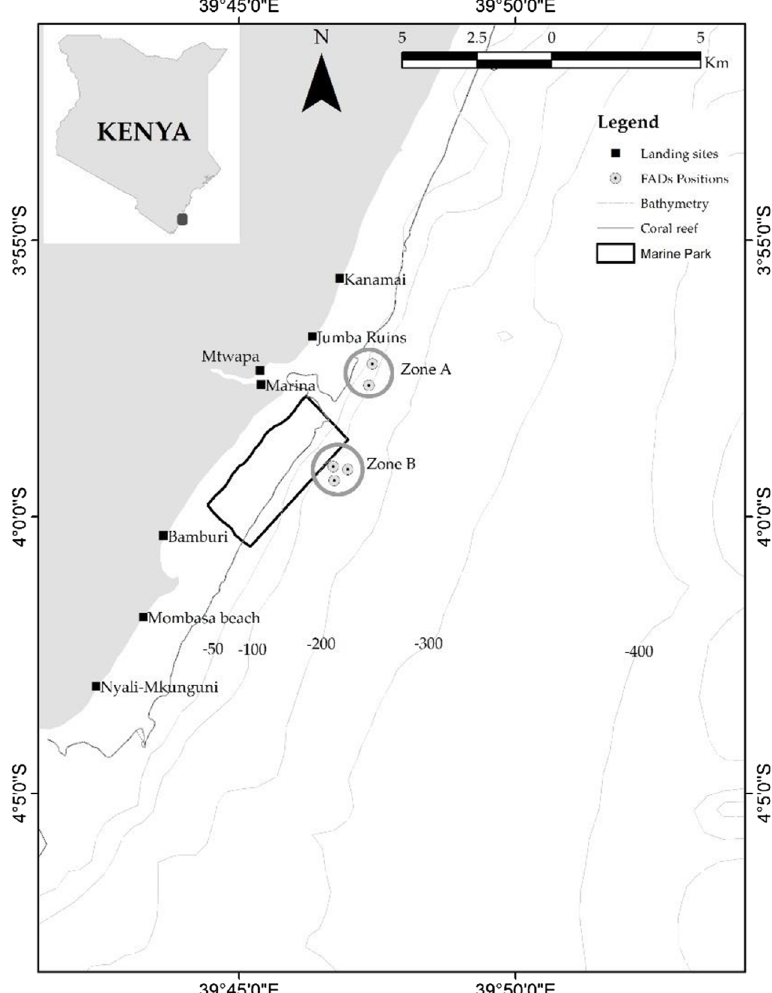
Fig. 1. Map showing the two sampling zones (A and B) fi shed by anchored fi sh aggregating devices (AFADs) in coastal